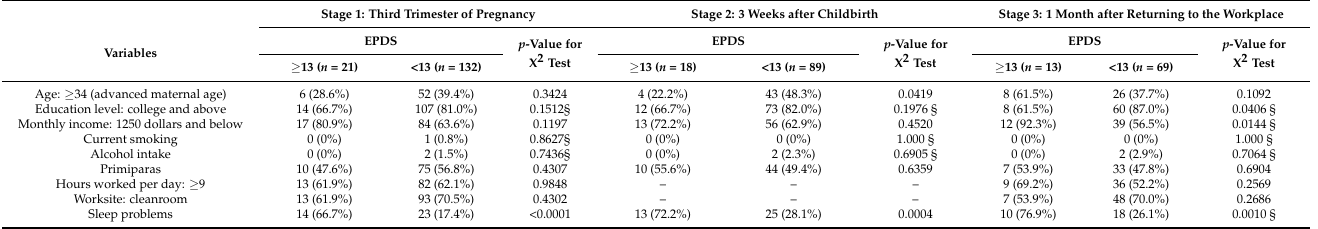
Figure 2. The cohort ( n = 82) of prevalence trends of perinatal depressive symptoms in third trimester of pregnancy, at 3 weeks after childbirth, and at 1 month after returning to work. Perinatal depressive symptoms in the third trimester of pregnancy (EPDS ≥ 13) were associated with: sleep problems ( p < 0.0001); perceived job strain ( p = 0.0003); lack of support from family or friends ( p = 0.0130); and lack of support from spouse ( p = 0.0326; Table 3). Perinatal depressive symptoms at 3 weeks after childbirth (EPDS ≥ 13) were associated with: advanced maternal age ( p = 0.0419); sleep problems ( p = 0.0004); and lack of support from family or friends ( p < 0.0001; Table 3). Perinatal depressive symptoms at 1 month after returning to the workplace (EPDS ≥ 13) were associated with: education level ( p = 0.0406); monthly income ( p = 0.0144); sleep problems ( p = 0.0010); perceived job strain ( p = 0.0003); lack of support from family or friends ( p = 0.0428); and lack of support from spouse ( p < 0.0001; Table 3). The effects of sleep problems, perceived job strain, and important support from others on the three stages of perinatal depressive status were further evaluated using multiple logistic regressions (Table 4). During the third trimester of pregnancy, sleep problems (OR = 6.2, 95% CI = 2.1–19.3), perceived job stress (OR = 4.4, 95% CI = 1.5–14.3), and lack of support from family or friends (OR = 7.0, 95% CI = 1.3–40.8) were significantly associated with perinatal depressive symptoms. Sleep problems (OR = 6.0, 95% CI = 1.7–23.5) and lack of support from family or friends (OR = 27.6, 95% CI = 4.1–322.3) were associated with an increased risk of perinatal depressive symptoms at 3 weeks after childbirth. After returning to the workplace, the only significant risk factor for perinatal depressive symptoms was perceived job strain (OR = 18.2, 95% CI = 2.2–435.7) after controlling for all covariates (education, monthly income, sleep problems, and lack of support from family or friends and spouse) in the multiple regression model. Table 3. Pregnancy status, self-reported mental and physical conditions, and perceived job strain and workplace support among 153 pregnant employee study participants and the Edinburgh Postnatal Depression Scale (EPDS)